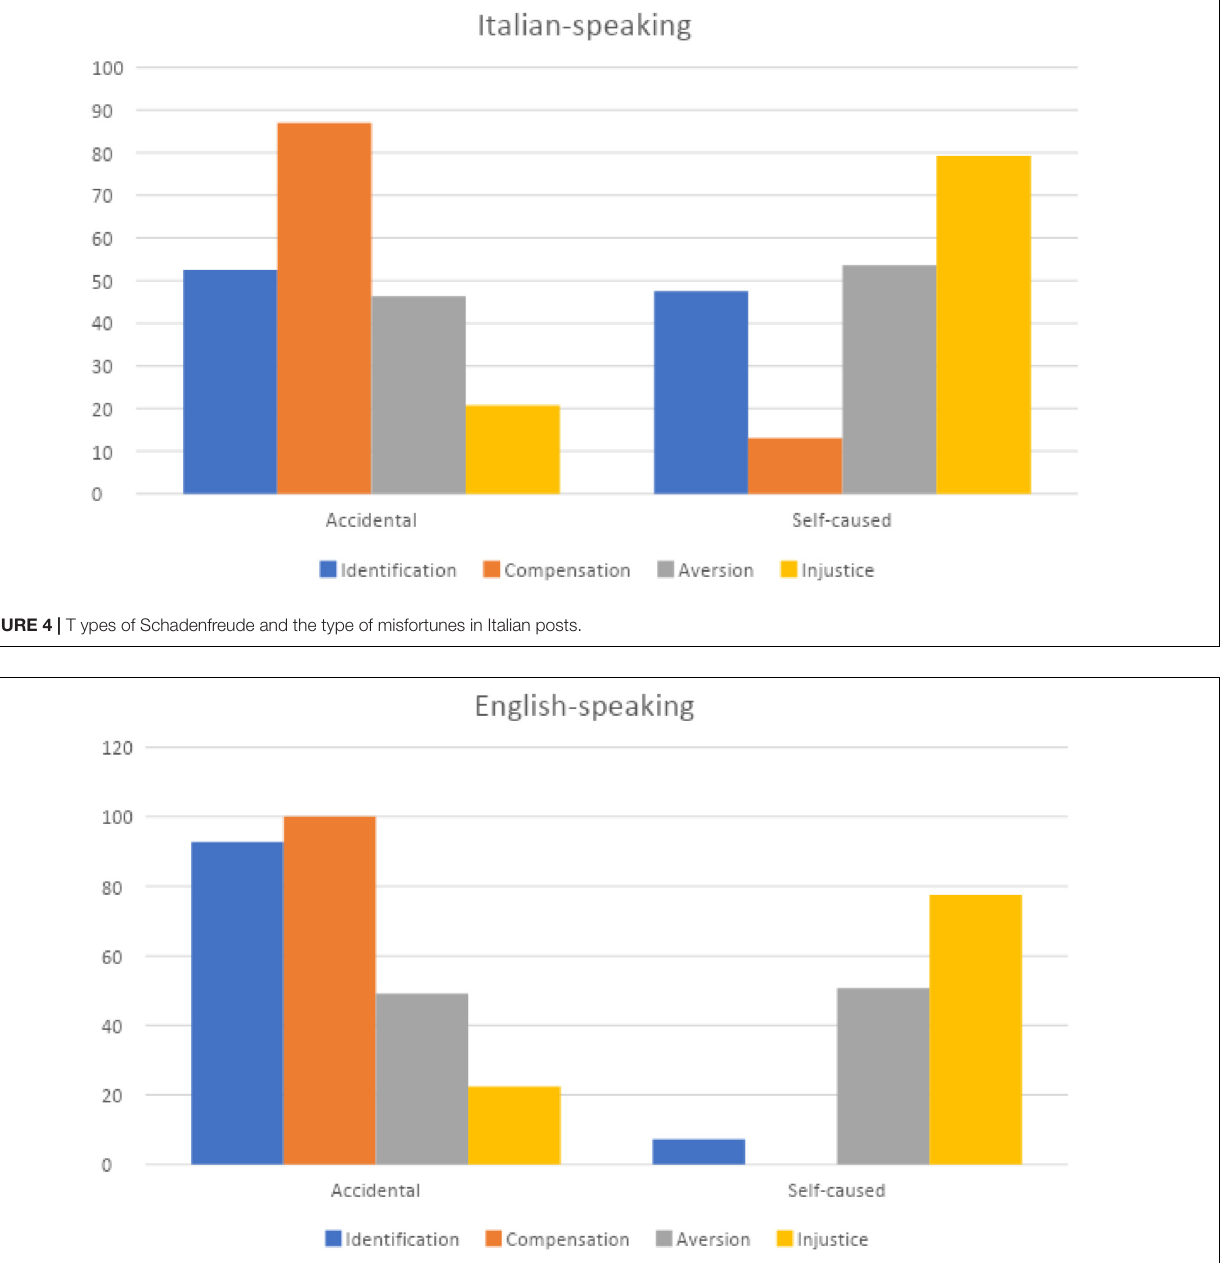
FIGURE 5 | Types of Schadenfreude and types of misfortunes in English-speaking